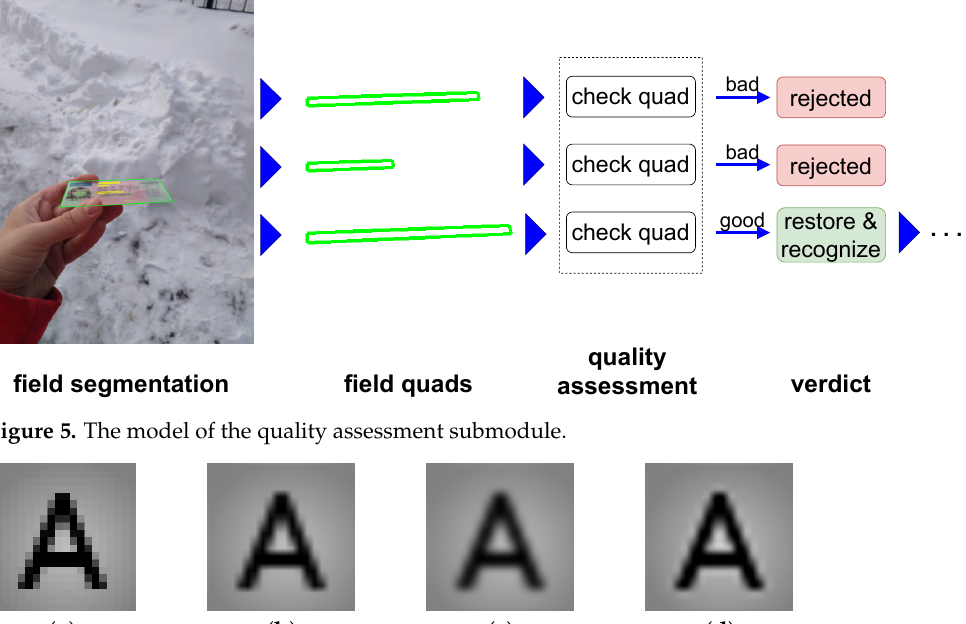
Figure 6. Interpolation examples [38]. ( a ) Nearest pixel, ( b ) bilinear, ( c ) B-spline, and ( d )